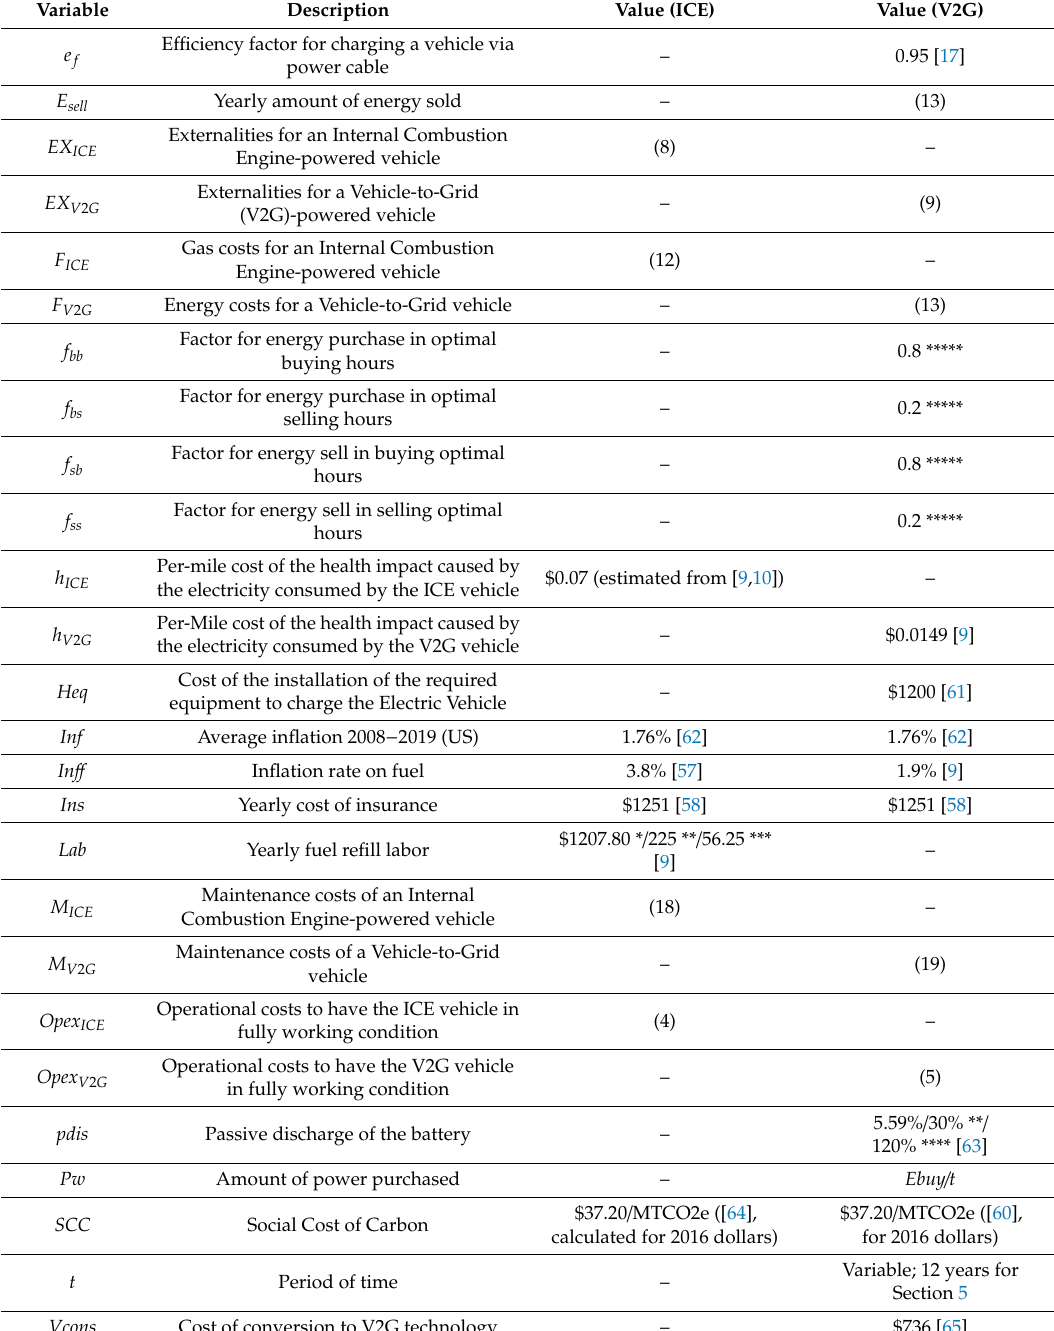
Figure 2. At the same time, Table A1 is showing in the Appendix A how numerical calculations vary on a yearly basis as